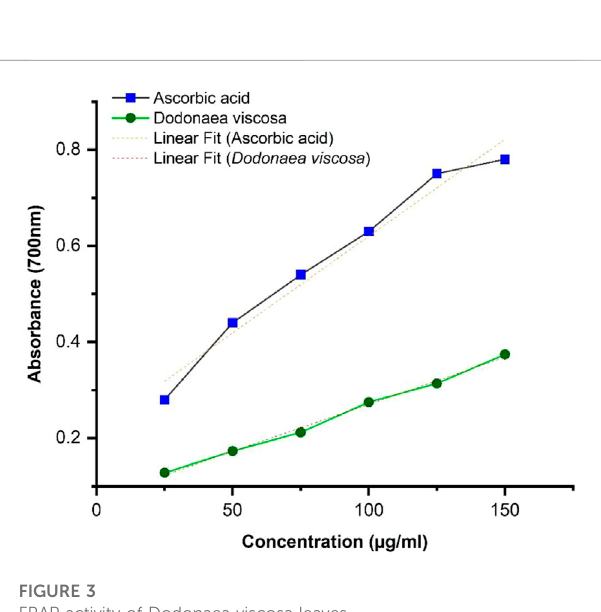
FIGURE 3 FRAP activity of Dodonaea viscosa